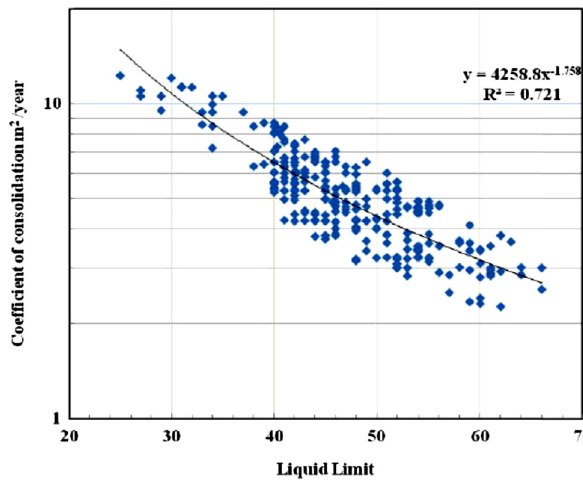
Figure 2: Coe ffi cient of consolidation against LL for Iraqi soils ( Al - Tae ’ e and Al - Ameri [ 20 ]) .